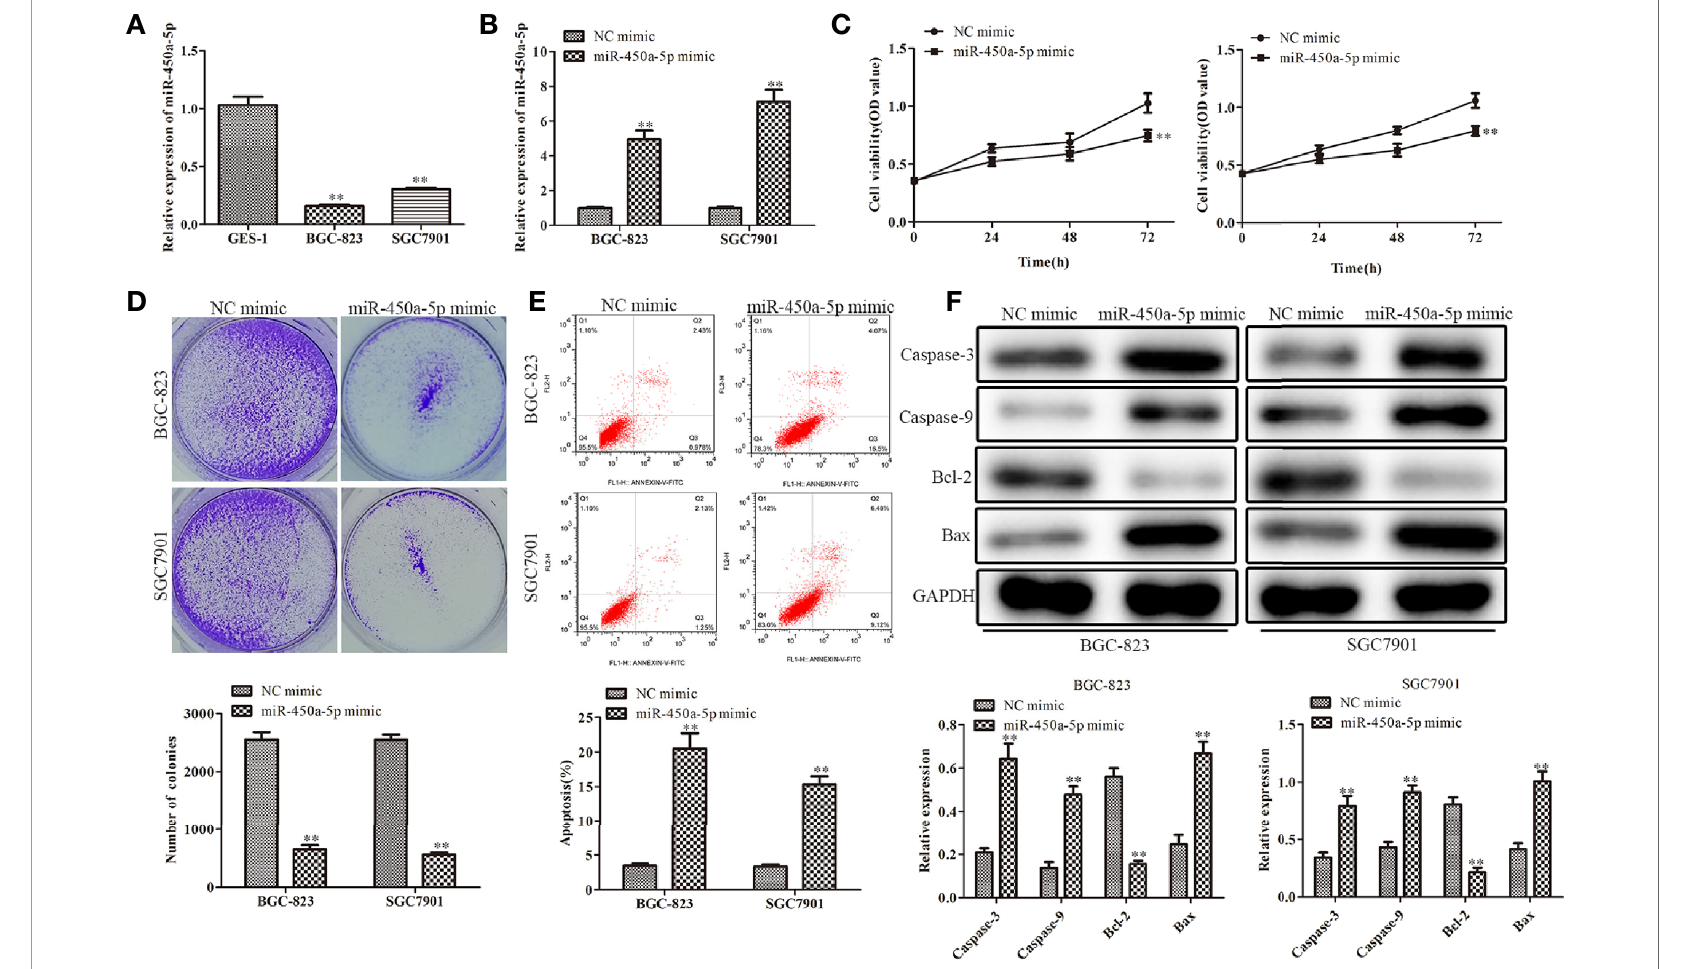
FIGURE 1 | Overexpression of miR-450a-5p inhibits cell proliferation and promotes apoptosis of gastric cancer. (A) The expression of miR-450a-5p measured by RT-qPCR in gastric cancer cell lines (BGC-823 and SGC-7901) and a human gastric epithelial cell line (GES-1). ** P <0.01 vs. GES-1 group. (B) The expression of miR-450a-5p assessed by RT-qPCR assay. ** P <0.01 vs. miR-NC group. (C – E) CCK-8, colony formation, and fl ow cytometry assays detected the cell proliferation and apoptosis in BGC-823 and SGC-7901 cells. ** P <0.01 vs. miR-NC group. (F) Western blot analysis evaluated the expression of apoptosis- associated proteins in BGC-823 and SGC-7901 cells. ** P <0.01 vs. miR-NC